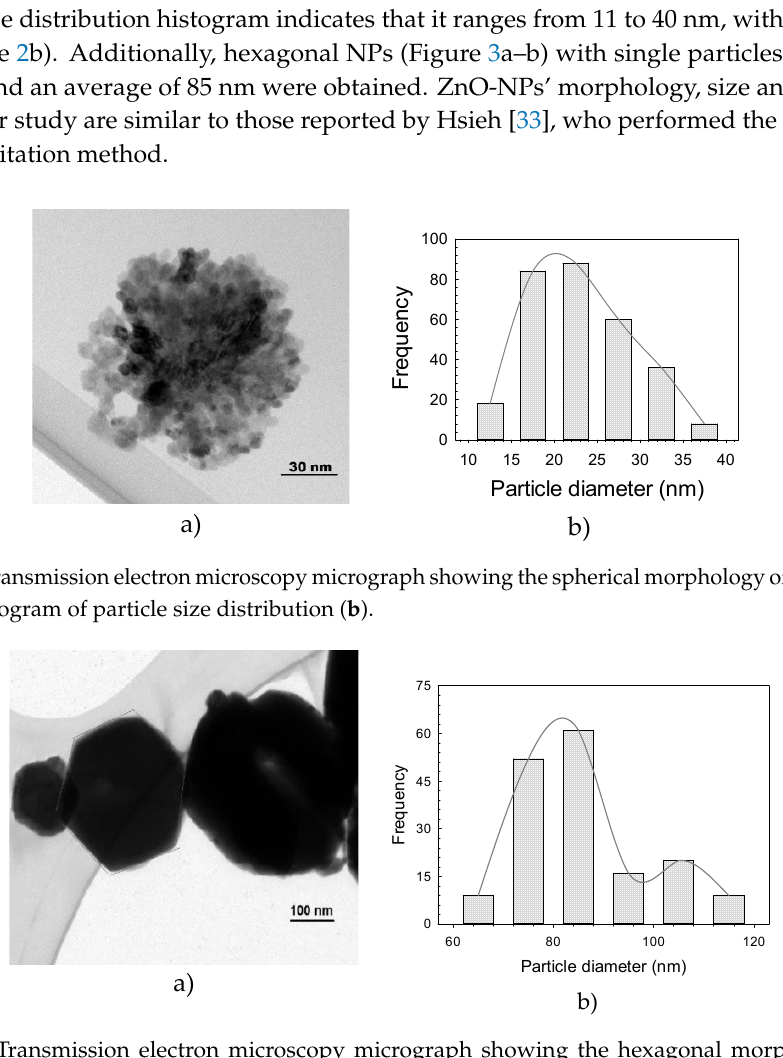
Figure 3. Transmission electron microscopy micrograph showing the hexagonal morphology of ZnO-NPs ( a ), and histogram of particle size distribution ( b ).